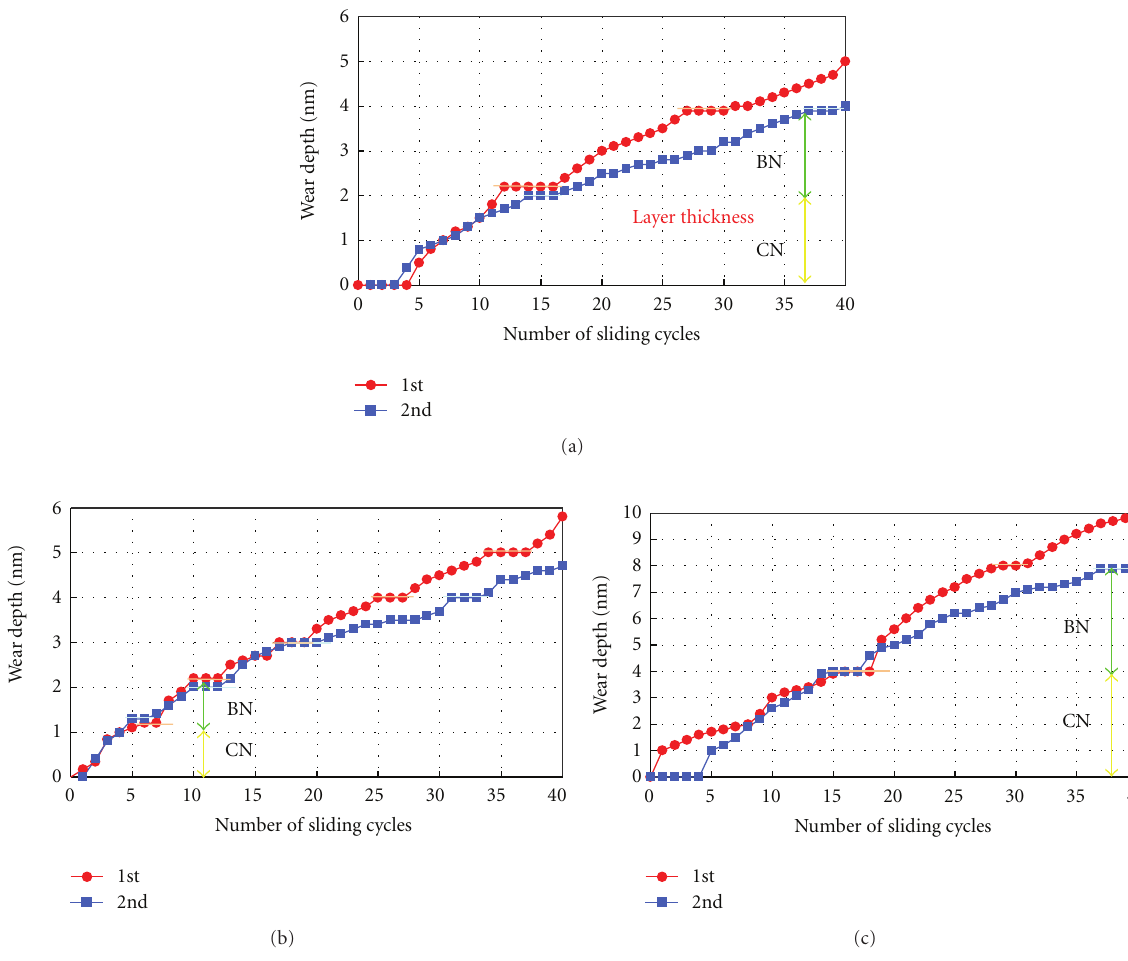
Figure 12: Nanowear depth dependence on number of scanning cycles for (a) 4-nm-period, (b) 2-nm-period, and (c) 8-nm-period multilayer